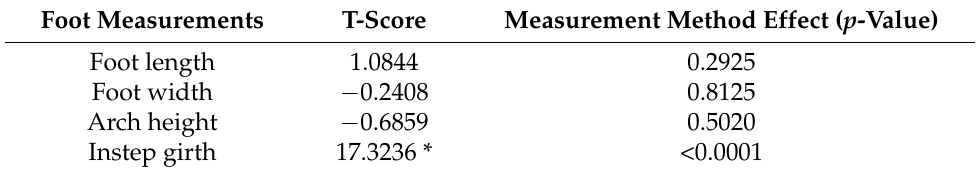
Table 4. Paired t -test for comparing two measurement methods (MM, AM) on foot